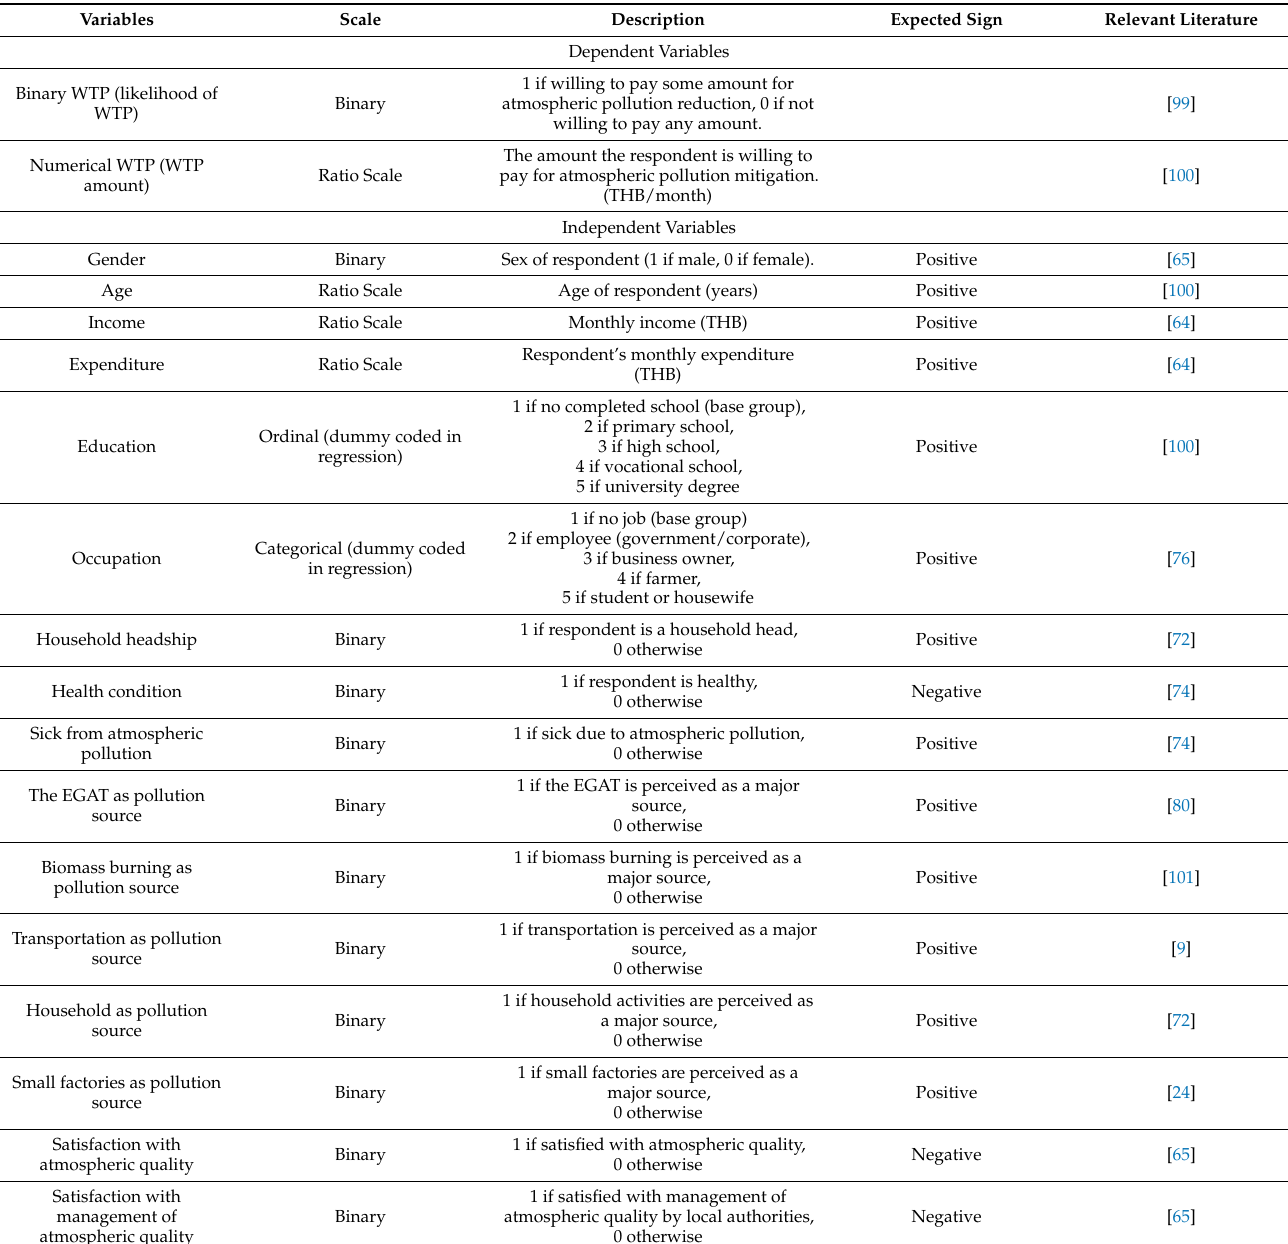
Table 4. The dependent and independent variables included in the analysis of factors associated with individual willingness to pay (WTP) for mitigation of atmospheric pollution in Mae